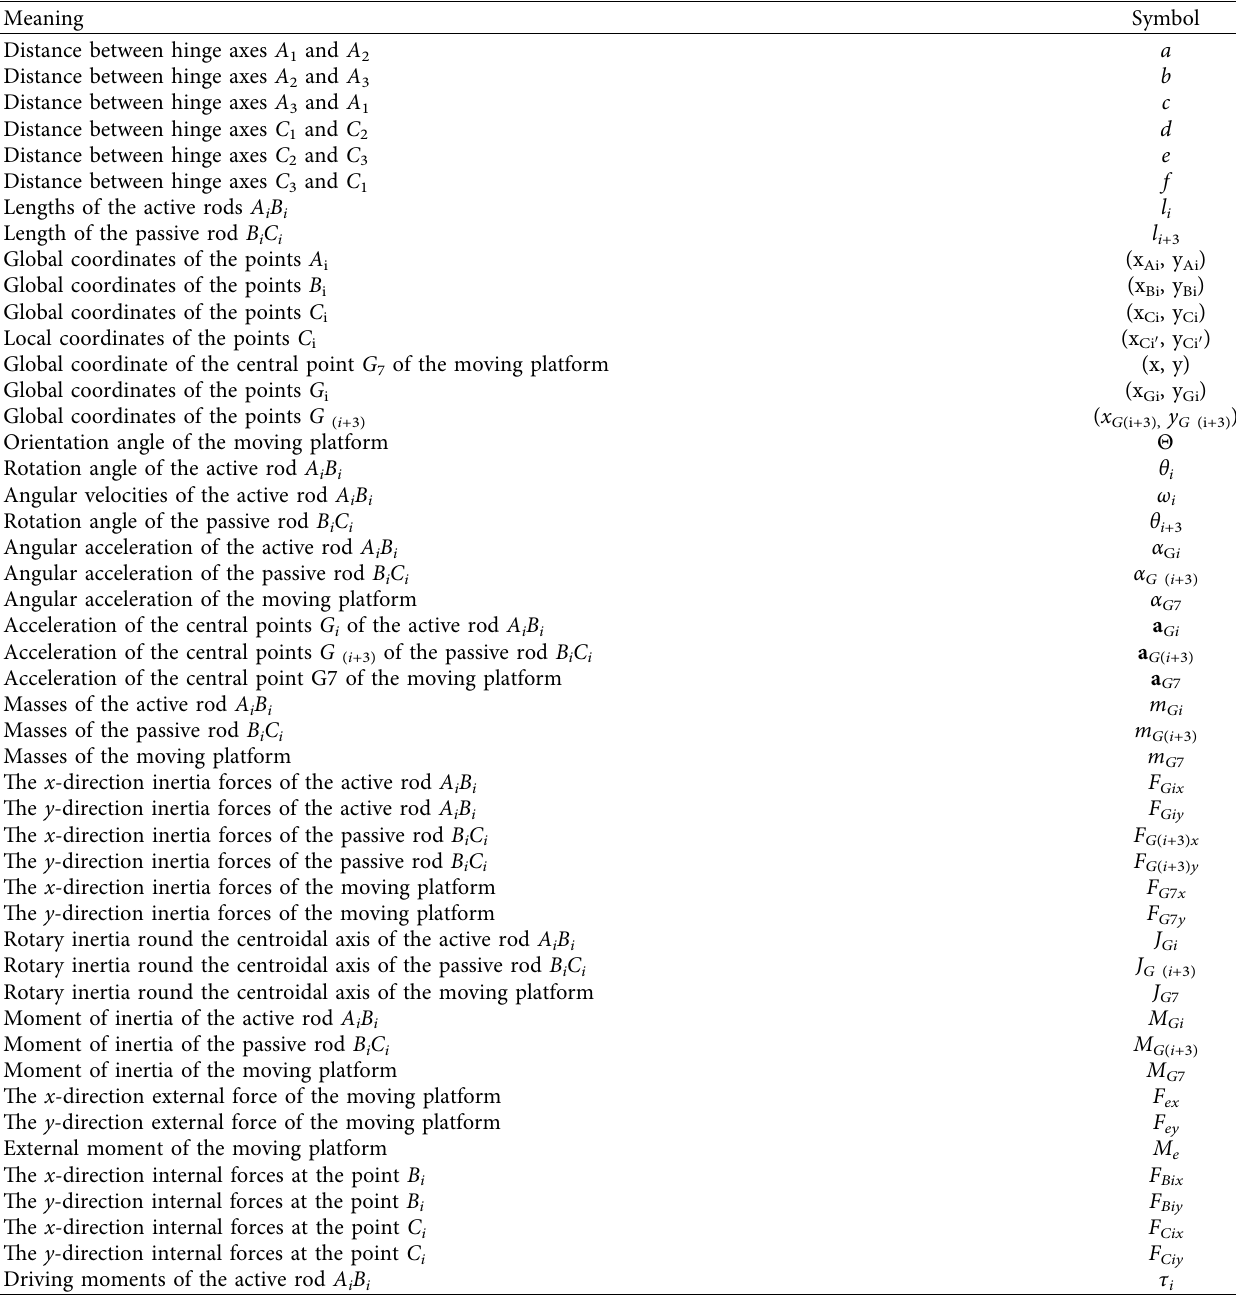
Table 1: Parameters of dimension, kinematics, and dynamics for the 3-RRR PPM (where i � 1, 2,